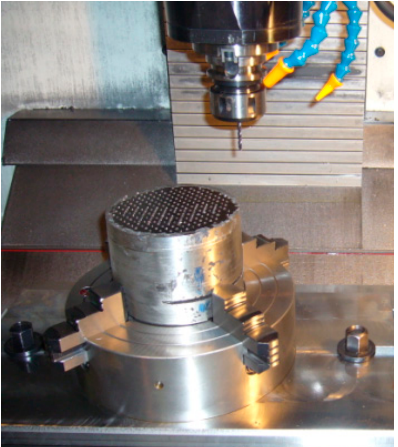
Figure 2. Experimental tests in a Kondia B640 multitasking milling center.